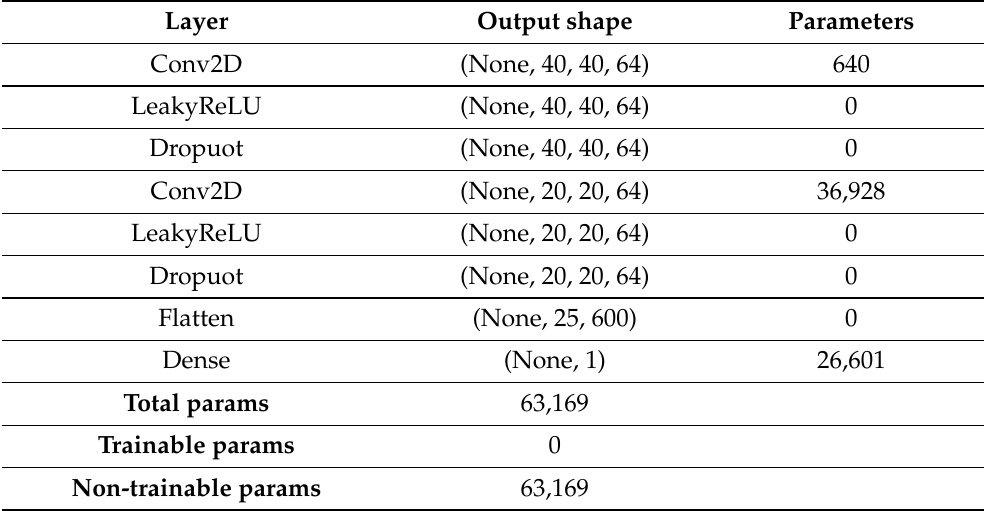
Table 7. Structure of the GAN discriminator